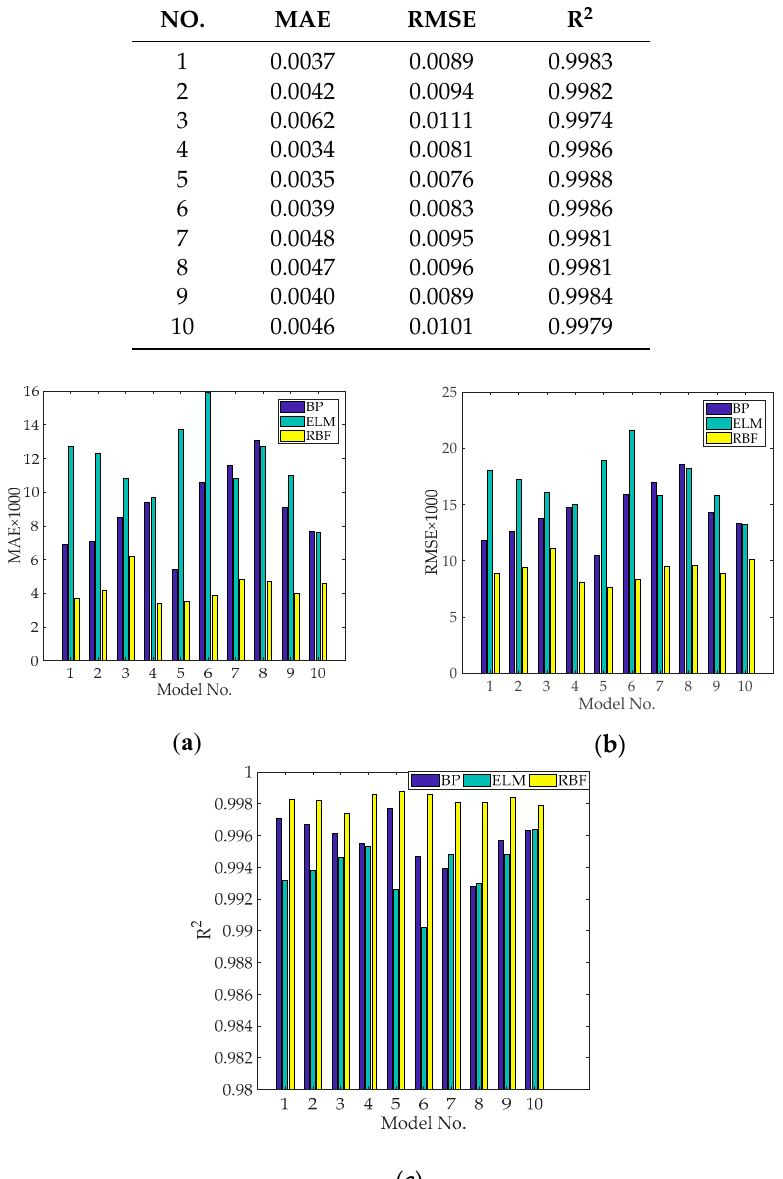
Table 6. Performance index data of radial basis function neural network (RBFNN) sub–models (Validation set).